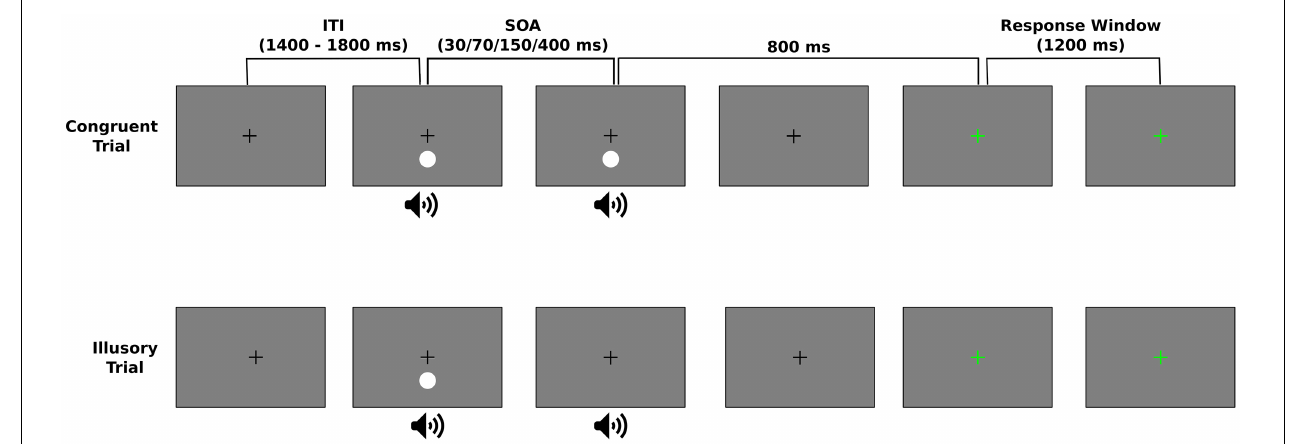
FIGURE 1 | Experimental design of the Sound Induced Flash Illusion (SIFI) task. During a trial, the visual stimulus (white circle) was presented below the fixation cross while the pure tone auditory beep was presented via speakers centered underneath the display. Trials were either a congruent or illusory trial. Congruent trials could either be a single flash-beep pair (1F1B) or two sequential flash-beep pairs (2F2B) that were separated by a variable stimulus onset asynchrony (SOA) (top panel). During the illusory trials, a flash-beep pair was first presented followed by a second auditory beep at some SOA (bottom panel). Regardless of trial type, participants were asked to respond as to how many flashes they perceived during the trial. To prevent motor artifacts, this response was entered 800 ms following the end of the stimulus presentation, indicated by a change in the color of the fixation from black to green. The response window was 1,200 ms and trials were separated by a variably intertrial interval (ITI) between 1,400 and 1,800 ms.